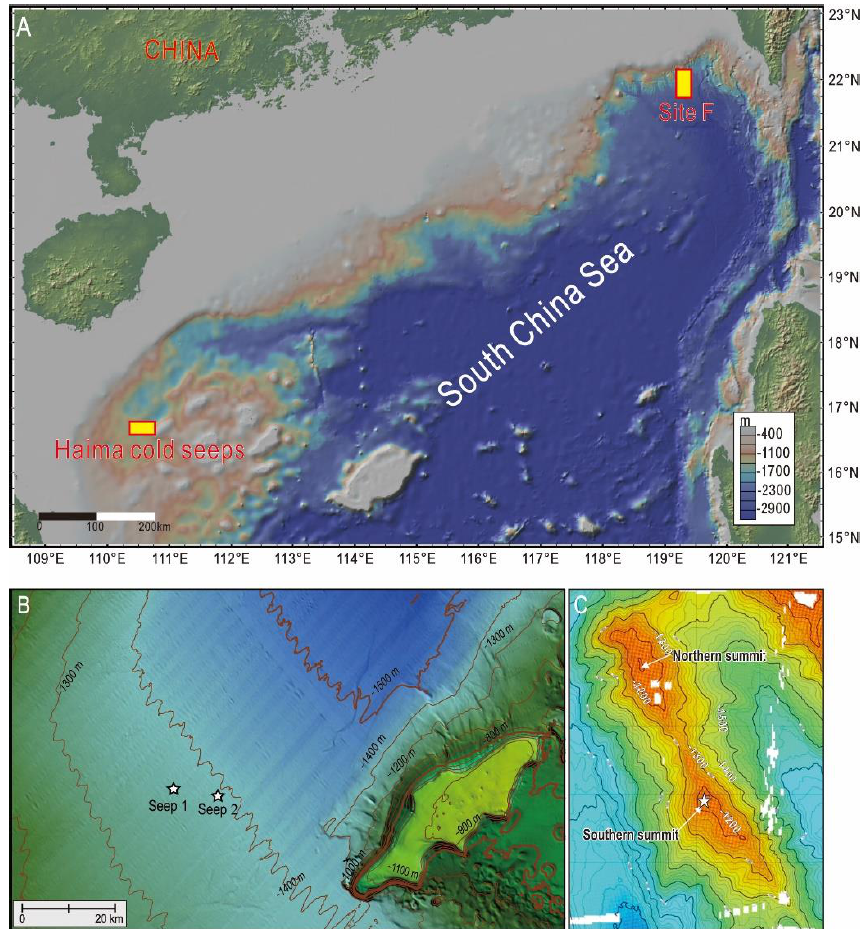
Figure 1. ( A ) Location of the two seep areas, Site F (1125 m) and Haima (1400 m). ( B ) Bathymetry map of the two active vents of the Haima cold seeps and their surroundings (provided by Professor Wei Li) with stars denoting the locations of the two vents. ( C ) Bathymetry map of the three active vents at Site F and their surroundings [44], which are located at the Southern summit of the Formosa ridge.